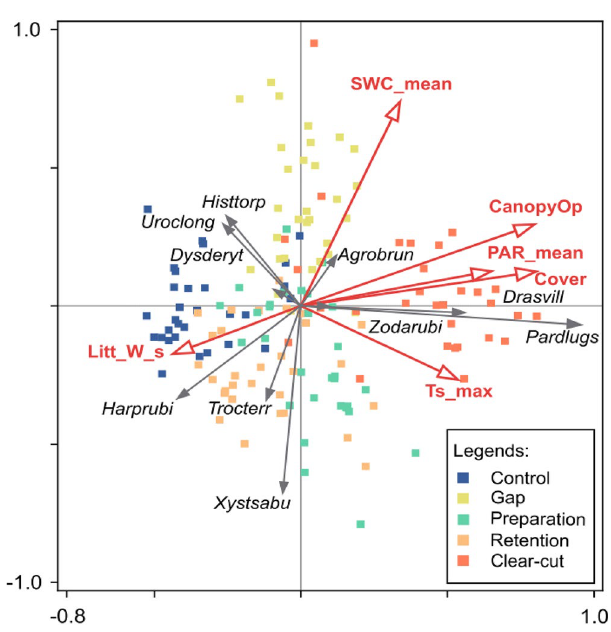
Figure 4. Ordination tri-plot of RDA analysis on the response of the 10 most dominant spider species to the environmental conditions of plots (separately for the experimental years), with block and year included as co-variables in the analysis. The yearly position of plots in the ordination space is colour coded according to forestry treatments. Abbreviated species (for family and author see Table S1): Uroclong— Urocoras longispina ; Pardlugu— Pardosa lugubris ; Trocterr— Trochosa terricola ; Drasvill— Drassyllus villicus ; Histtorp— Histopona torpida ; Xystsabu— Xysticus sabulosus ; Harprubi— Harpactea rubicunda ; Agrobrun— Agroeca brunnea ; Zodarubi— Zodarion rubidium ; Dysderyt— Dysdera erythrina . See Table 2 for resolving abbreviated environmental variable